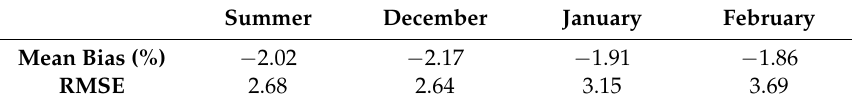
Figure 2. Comparison of summer and monthly means of albedo observed in Summer ( a ), December ( b ), January ( c ), and February ( d ) at GVN station with those derived from the CLARA-A2 dataset. Table 2. Assessment results of albedo (%) between CLARA-A2 dataset and GVN station.